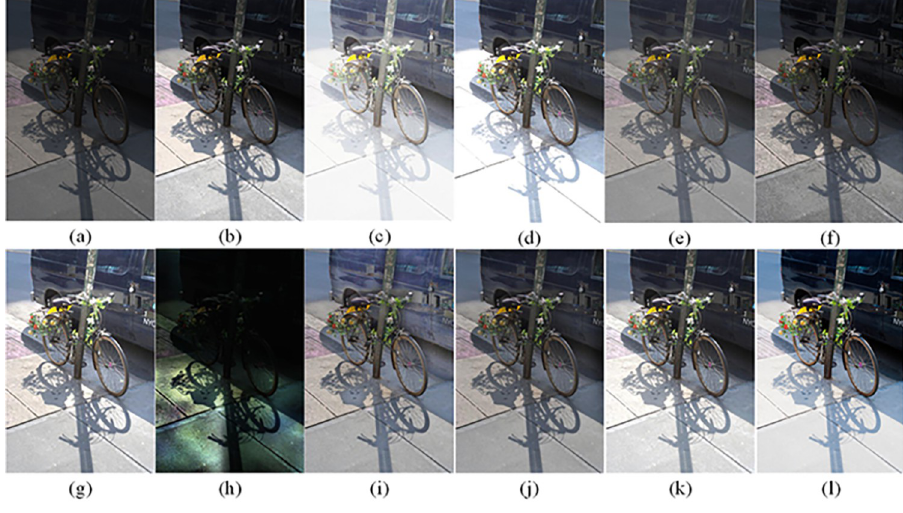
Fig 26. Comparisons of the ten algorithms in enhancing low-light image 16. (a) low-light image (b) AGCWD (c) Al-Ameen (d) BHE2PL (e) BIMEF (f) BPDHE (g) LIME (h) MSRCR (i) NPEA (j) SRIE (k) OURS (l) Normal light image.